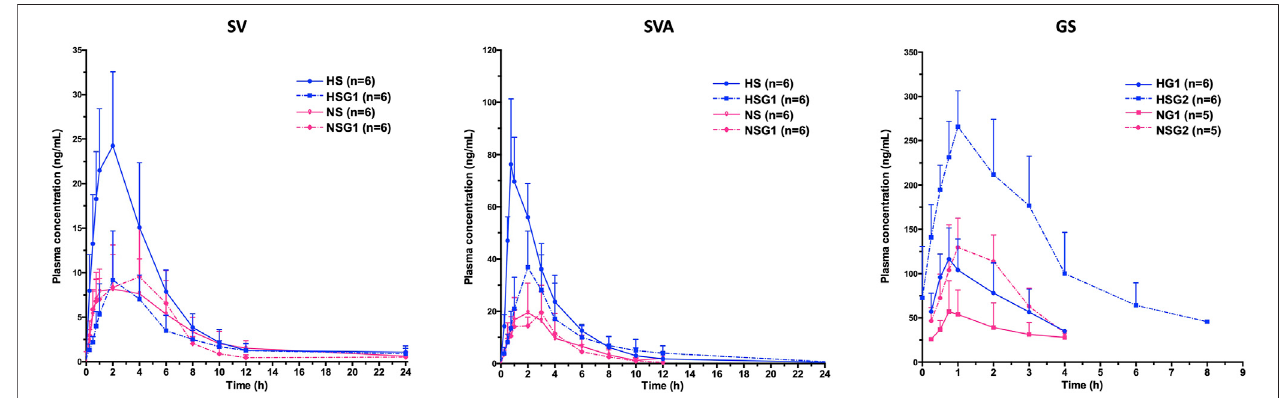
FIGURE 3 | Pharmacokinetic pro fi les of SV and SVA in healthy and NASH rats which received SV in the absence (HS and NS) and presence (HSG1 and NSG1) of GJ and those of GS in healthy and NASH rats which received GJ in the absence (HG1 and NG1) and presence (HSG2 and NSG2) of SV. H and N denoted healthy and NASH, respectively. C, S, and G indicated that the rats received vehicle, SV, and GJ, respectively.